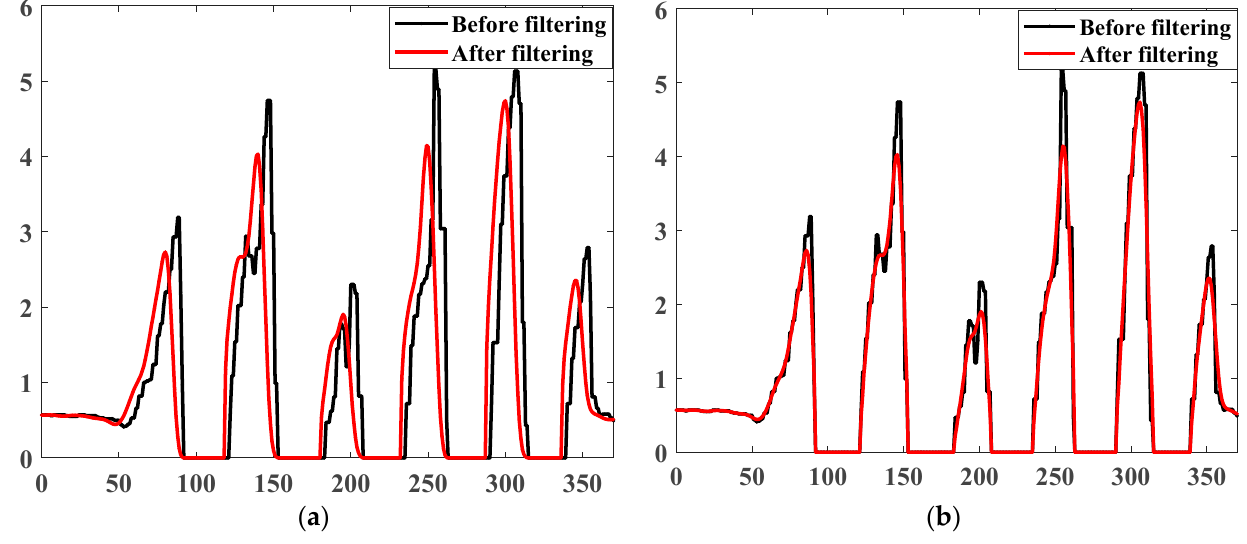
Figure 5. Comparison of filtering effect of AD8 channel of plantar pressure sensor. ( a ) Traditional moving average filtering; ( b ) improved sliding mean filtering.